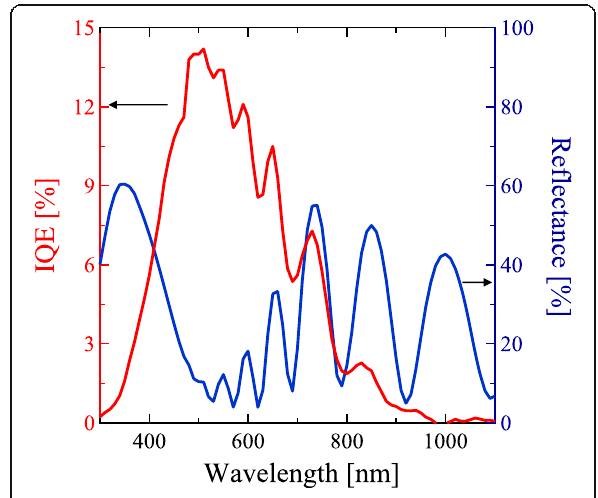
Fig. 6 Internal quantum efficiency and reflectance versus wavelength for the fabricated solar cell without thermal oxide layer. The IQE and reflectance were drawn with red and blue,